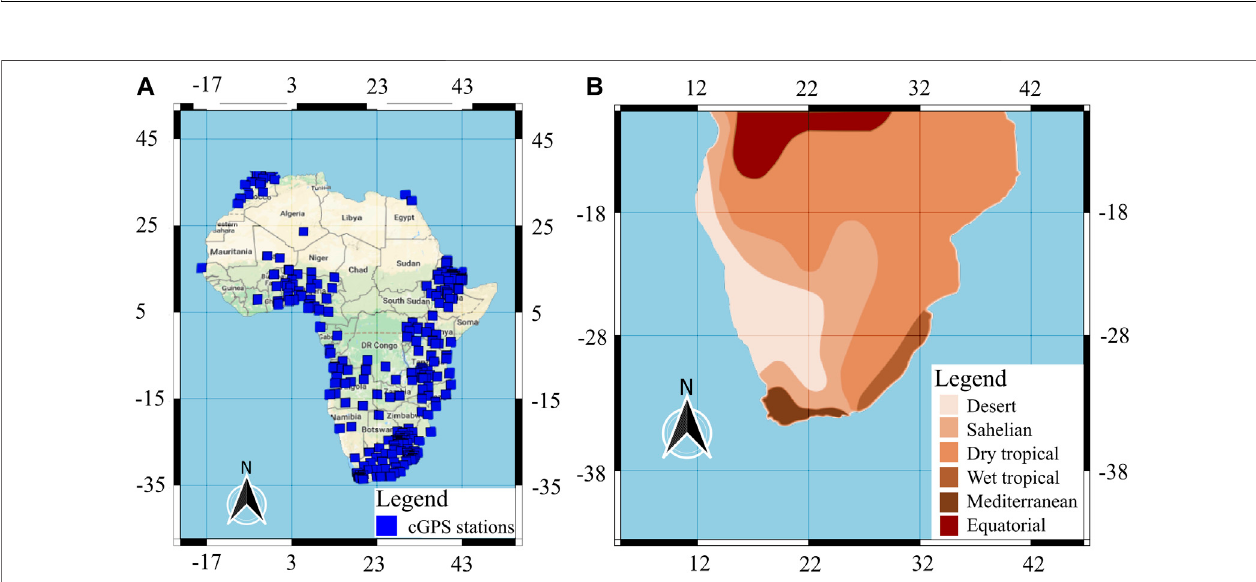
FIGURE 2 | (A) Location of cGPS station in the African continent. (B) Climatic zones in southern Africa (modi fi ed after Hepburn and Radloff, 1998). 27. Southern Africa is a largely semi-arid region, consisting of fi ve different climatic zones (i.e., the Mediterranean, Desert, Sahelian, Dry tropical, and Wet tropical climatic zones). Its general climate varies from dry arid conditions in the west to humid tropical conditions in the north and east